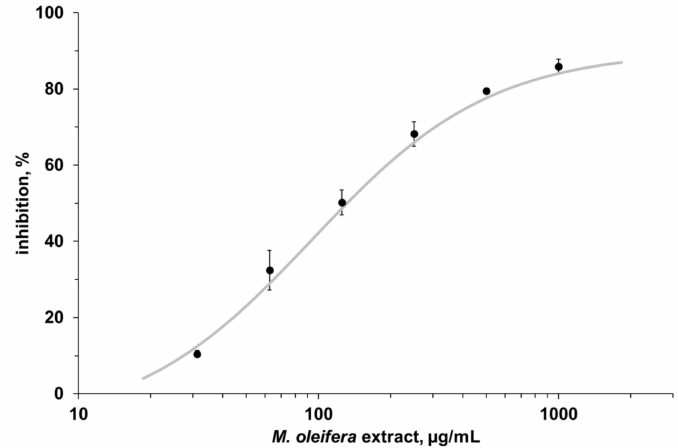
Figure 1. Representative inhibition profile of α -amylase activity in the presence of Moringa oleifera